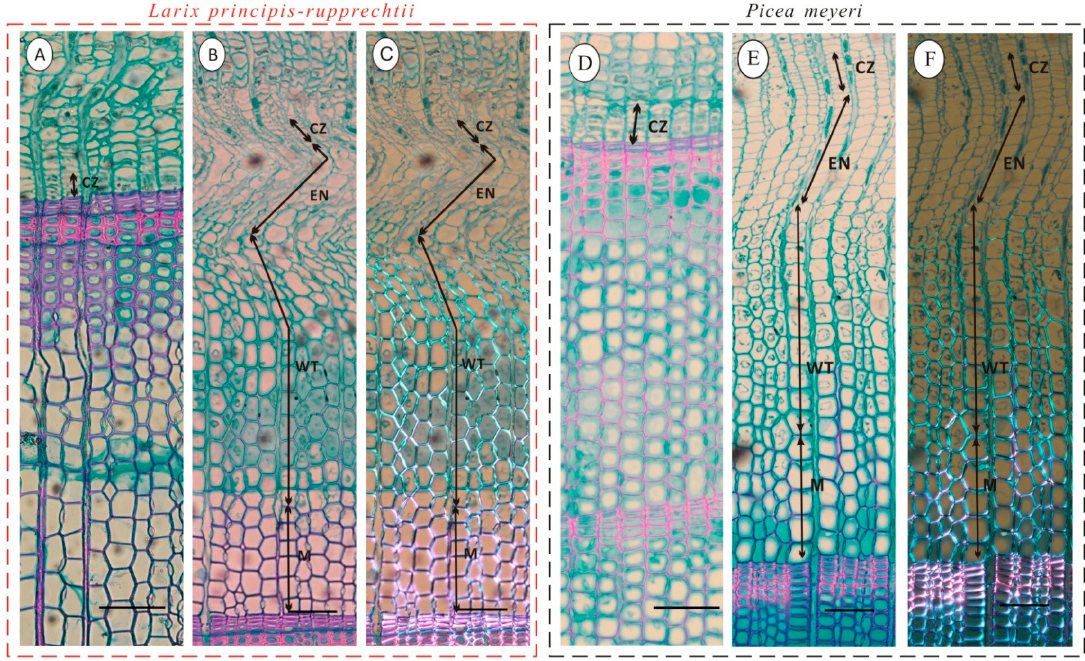
Figure 4. Phases of secondary growth in Larix principis-rupprechtii ( A – C ) and Picea meyeri ( D – F ) on the same date. ( A , D ): on 24 April, no new xylem cell production was observed and the cambial zone (CZ) consisted of seven to eight cells and five to six cells for larch and spruce, respectively; ( B , E ) and ( C , F ): on 20 July, enlarging (EN), wall-thickening (WT), and mature (M) cells under bright field and polarized light, respectively; scale bar = 100 µ m.